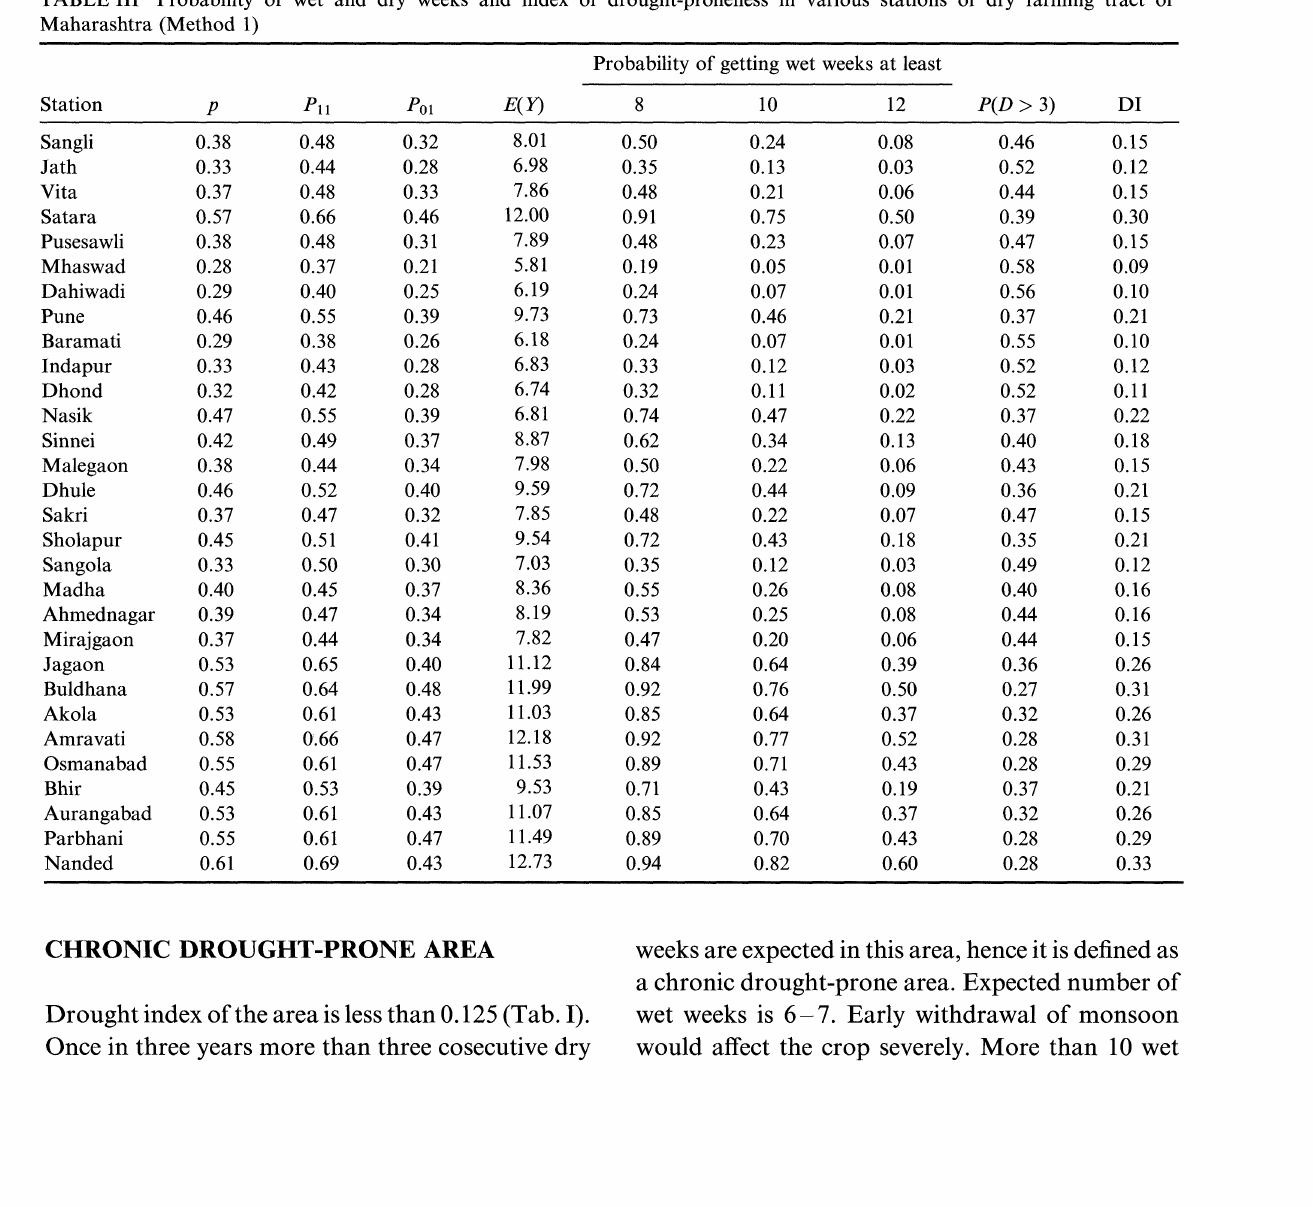
TABLE II Probability of wet and dry weeks and index of drought-proneness in various stations of Purulia and Giridih (Method 1) Station